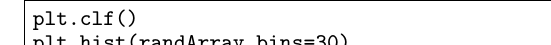
sums of the integers between 1 and 5. There is only one way to obtain the 10, namely 5+5. But there are several ways to obtain 5: 4+1, 3+2, 2+3, 1+4. An outcome near the middle of the set is more